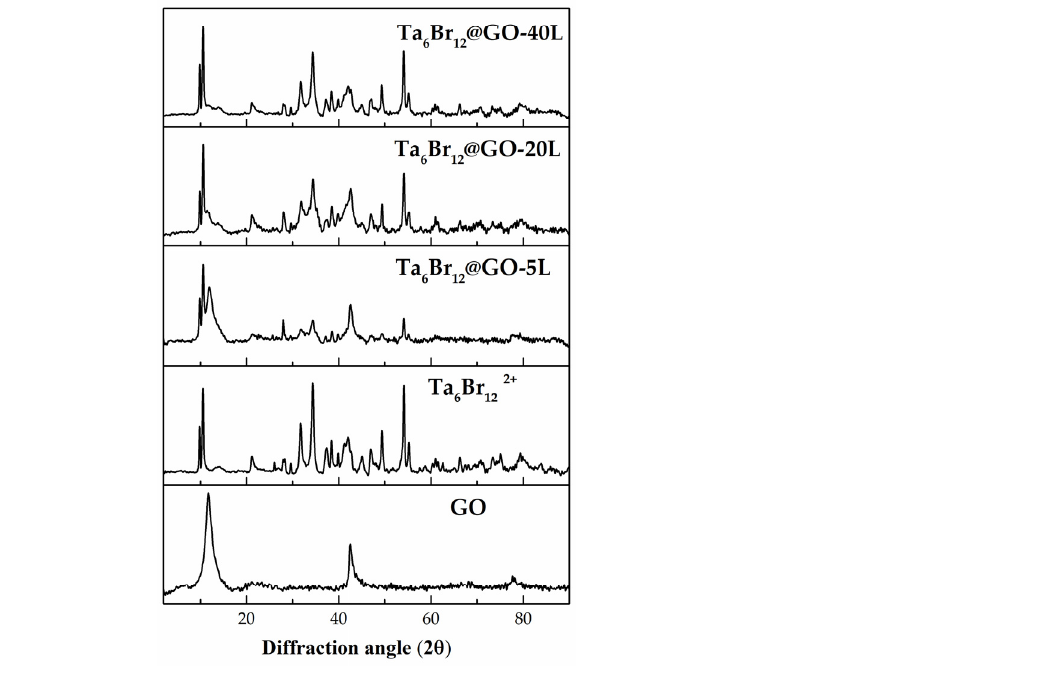
Figure 2. PXRD diffractograms of {Ta 6 Br i 12 }@GO, [{Ta 6 Br i 12 }Br a 2 (H 2 O) a 4 ] · 4H 2 O and GO materials.